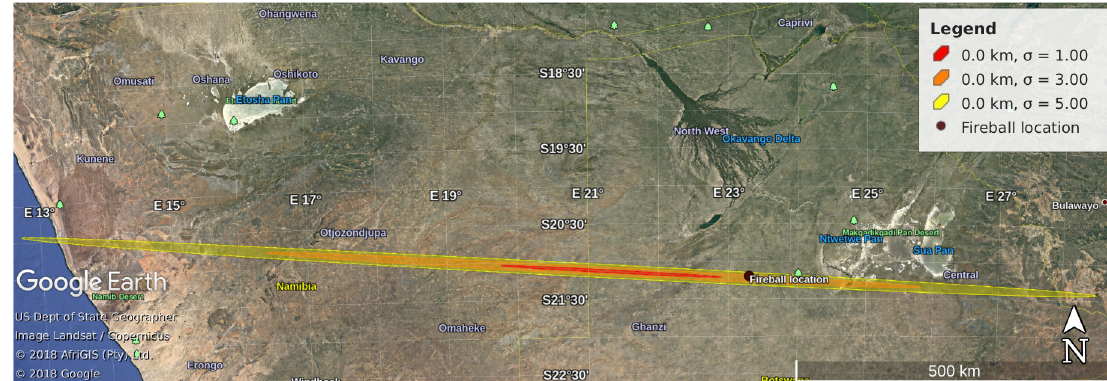
Figure 6. Google Earth 3D visualisation of 2018LA impact regions on ground for different values of the parameter σ that defines the confidence ellipsoid. The fireball location at an altitude of 28.7 km is also displayed. Figure from